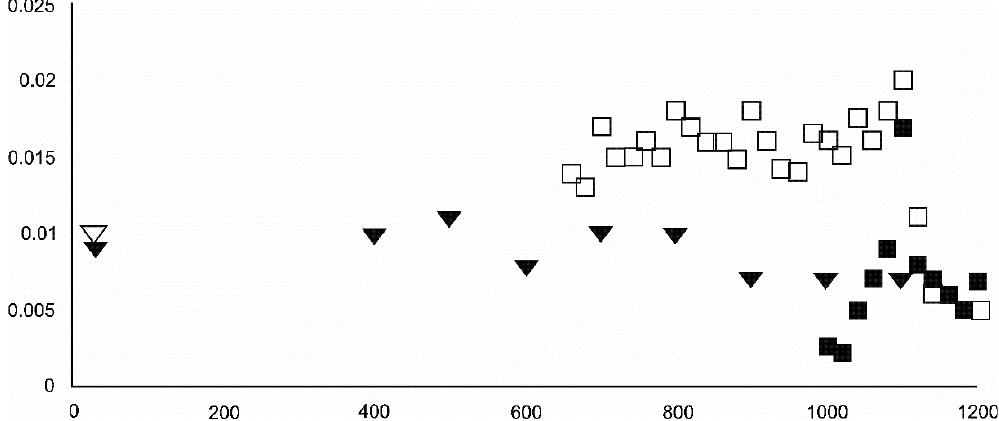
Figure 16. Relationship of temperature (bottom axis, in °C) to FWHM (left axis, as 2 θ angular difference) for olivine. LSCB data—filled symbols. USCB data—empty symbols. Squares—heating-related data. Triangles—cooling-related data.